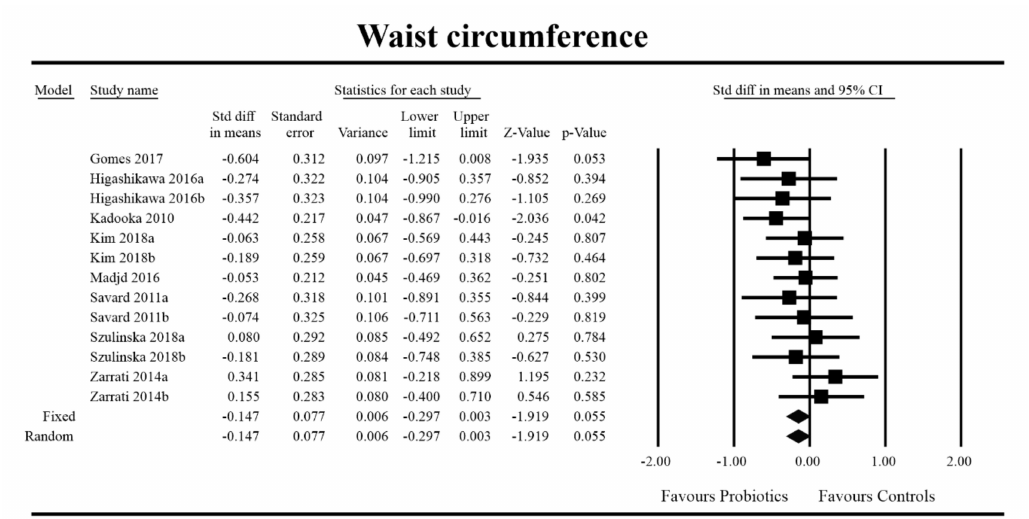
Figure 3. E ff ect size and di ff erence in means for BMI in persons taking probiotics vs. controls (endpoint data). Q = 12.996, df (Q) = 21, p = 0.909, I-squared = 0.0. BMI—body mass index. [31,44,49–51, 56,59–61,66–68,72,74,81,89].